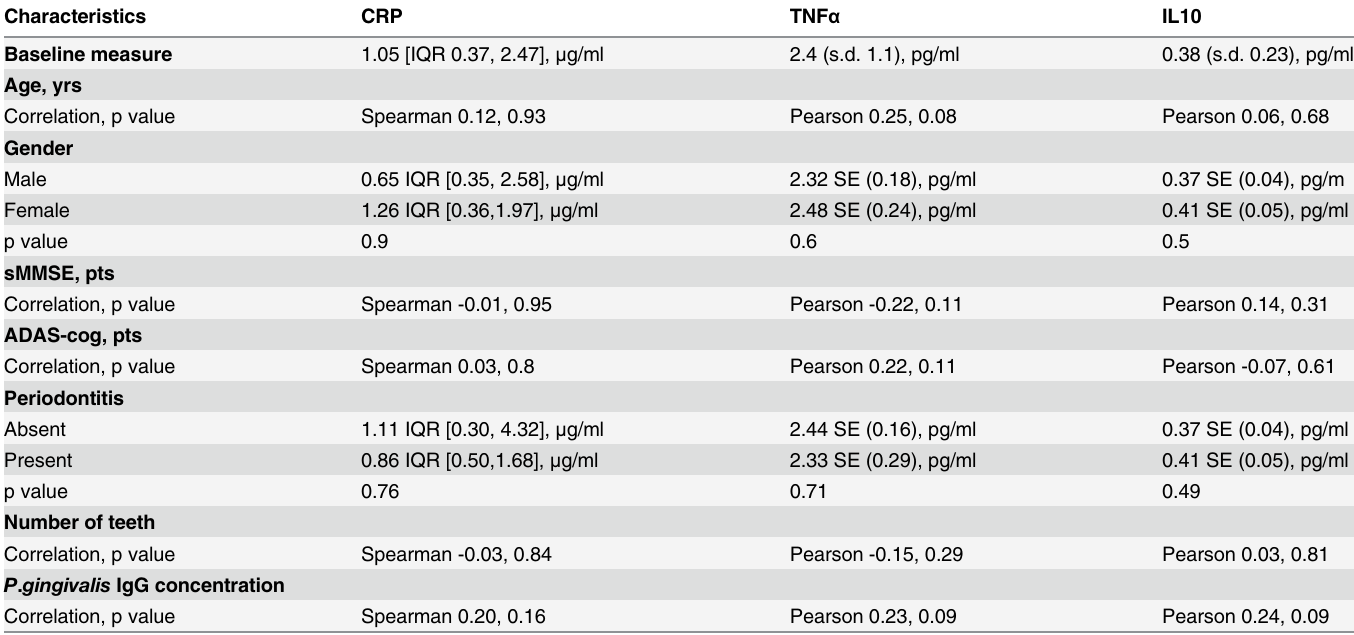
Table 3. Relationships between baseline serum inflammatory markers and baseline demographics; cognitive measures and dental health measures.